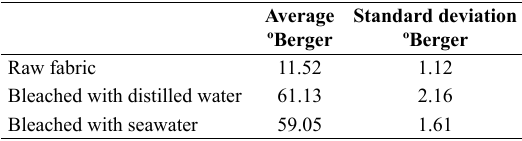
Table 4. Results of Berger scale.